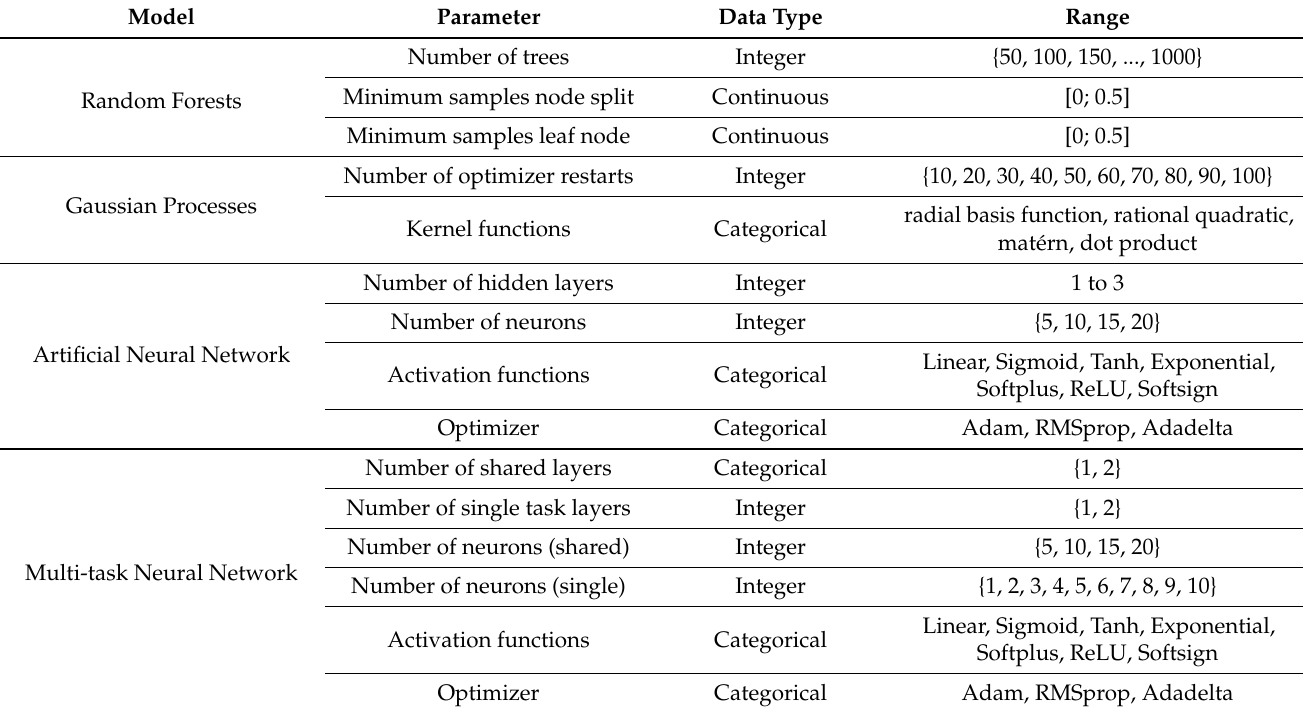
Table 2. Overview of the hyperparameters tested during the optimization. The final set of parameters used are given in Tables 4 and